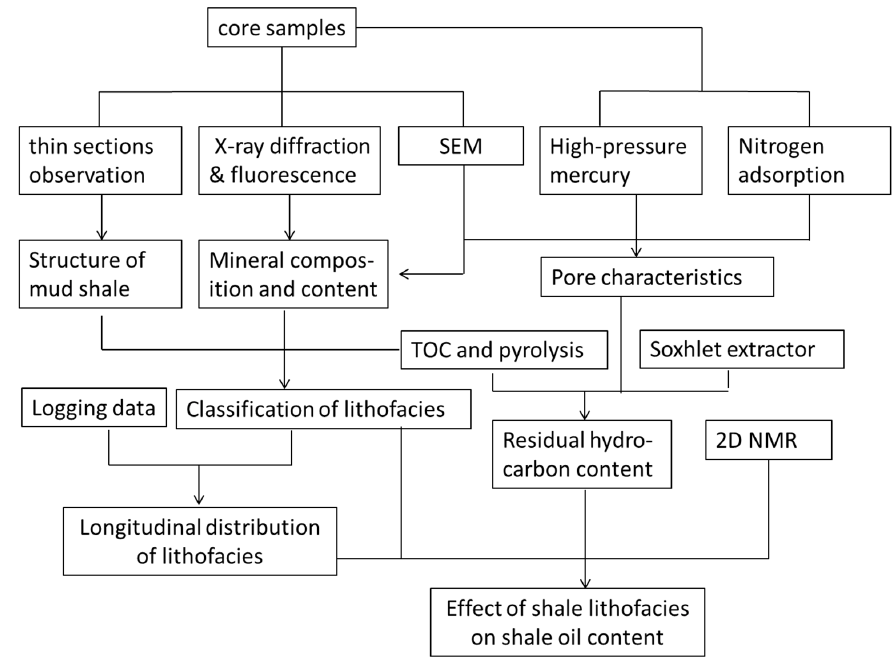
Figure 3. Schematic diagram of the experiments performed in this study.